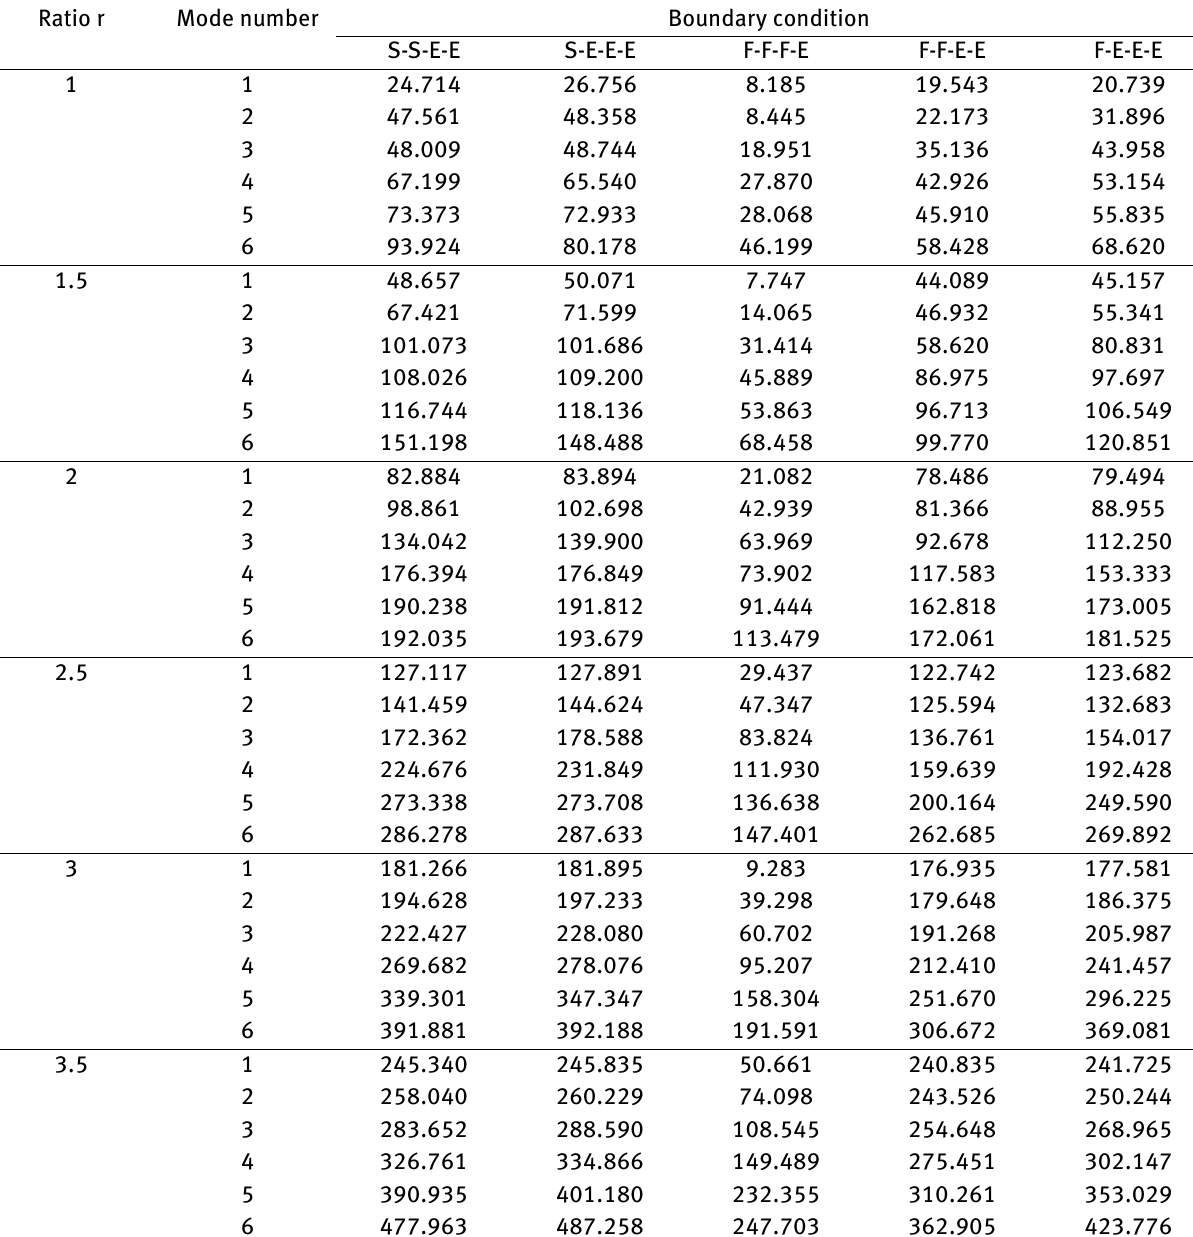
Table 9: The first six parameters Ω for the rectangular thin plates with elastic boundary conditions and different aspect ratios. Ratio